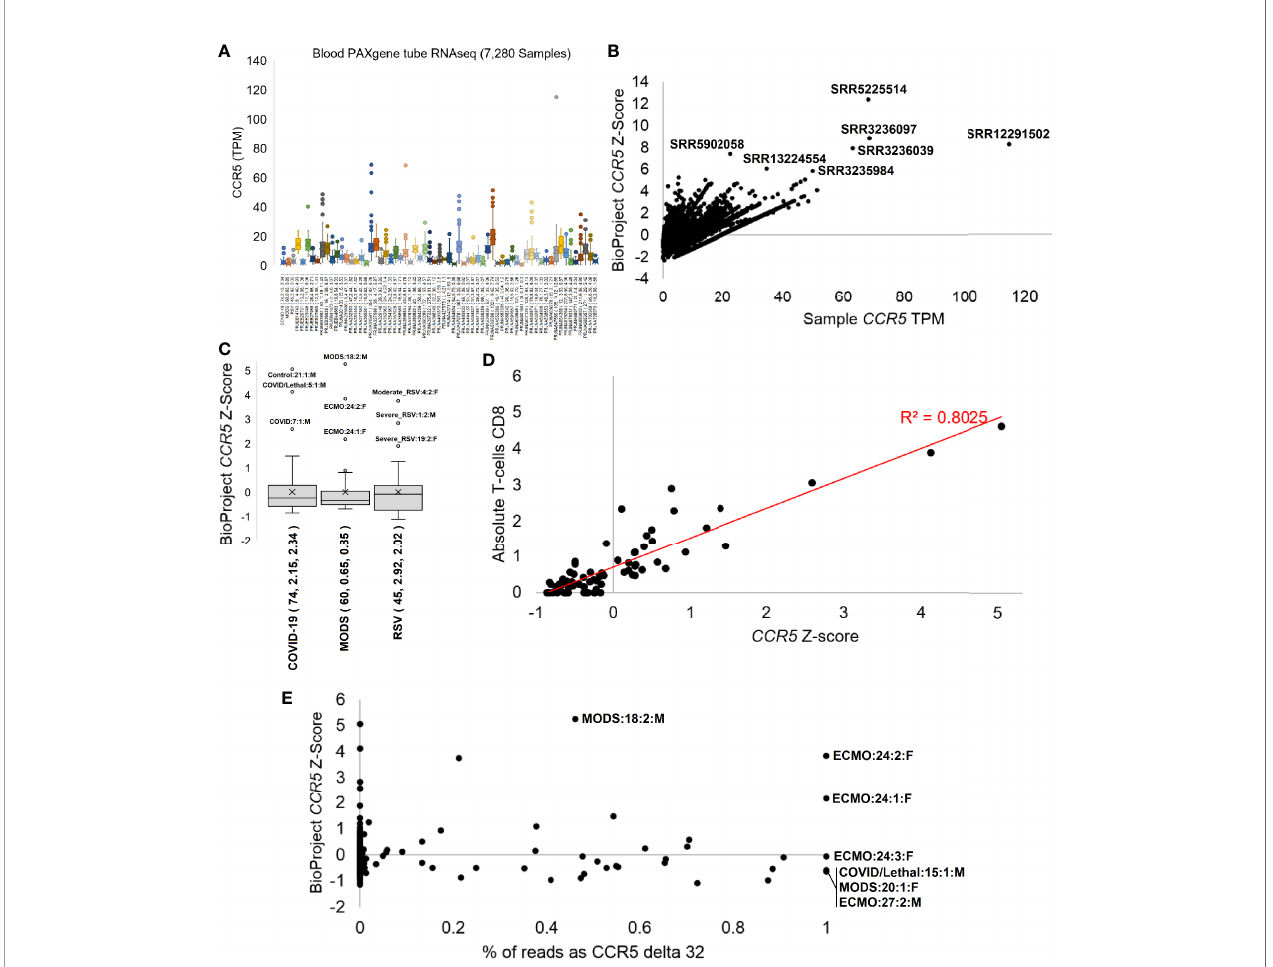
FIGURE 7 | CCR5 expression in blood PAXgene tube RNAseq. (A) Box and whisker plots for the expression (TPM) of CCR5 from various NCBI BioProjects that were generated by Illumina paired-end RNA-Seq from human blood collected PAXgene tube samples. Listed next to each BioProject code is the number of samples, average CCR5 expression, and standard deviation of CCR5 expression. (B) The TPM expression for each sample (x-axis) of panel (A) relative to the BioProject normalized Z-score (y-axis). The top seven samples based on Z-score are labeled. (C) The Z-scores for our three pilot precision transcriptome datasets, with outlier samples labeled. (D) The COVID-19 study analysis of CCR5 normalized expression relative to CIBERSORTx absolute CD8 T-cell values. (E) The percent of transcripts containing the delta 32 variant relative to wild type (x-axis) for samples of panel (C) relative to the BioProject normalized Z-Score. All homozygous samples for delta 32 are labeled as is the heterozygous sample with the highest study